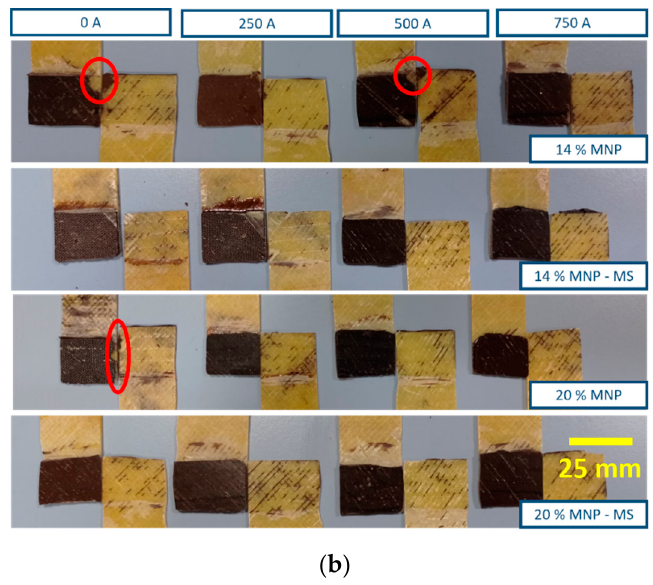
Figure 6. ( a ) LSS values and ( b ) images of the fracture surfaces showing the failure mode for the different conditions (the red circles denote the presence of cohesive failures).